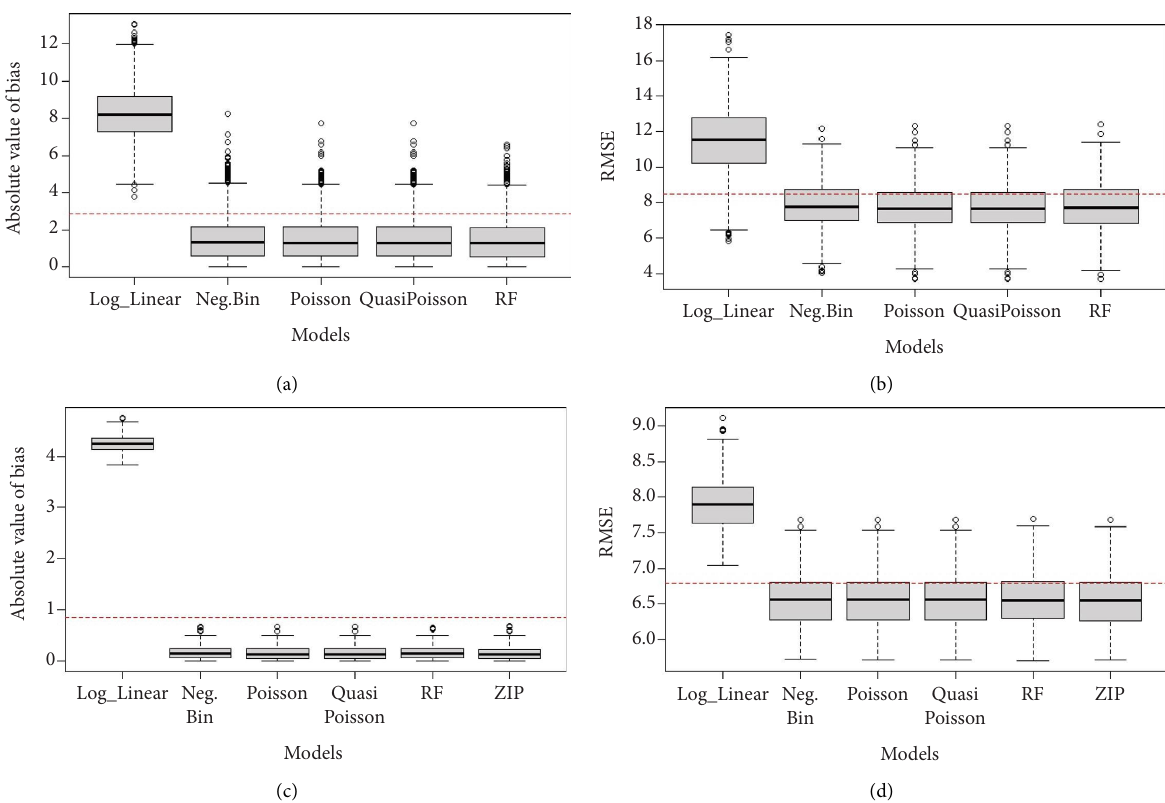
Figure 7: Predictive performance of RF compared to GLMs for tick burden and NMES1988 datasets. (a) Tick burden dataset: BIAS, (b) tick burden dataset: RMSE, (c) NMES1988 dataset: BIAS, and (d) NMES1988 dataset: